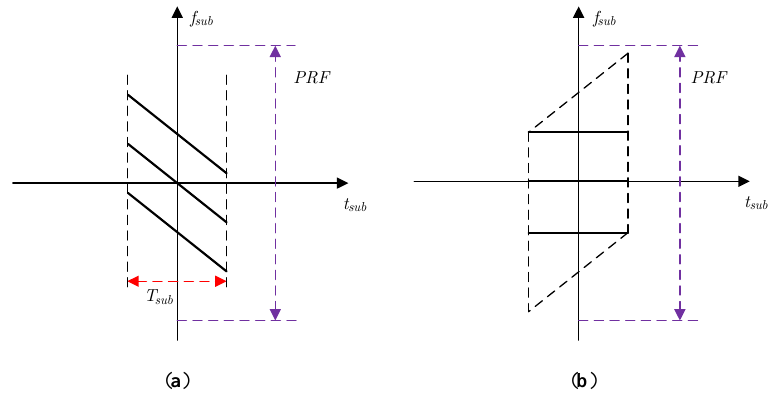
Figure 4. Time-frequency distribution for matched filtering: ( a ) unprocessed sub-aperture signal; ( b ) sub-aperture signal after matched filtering.